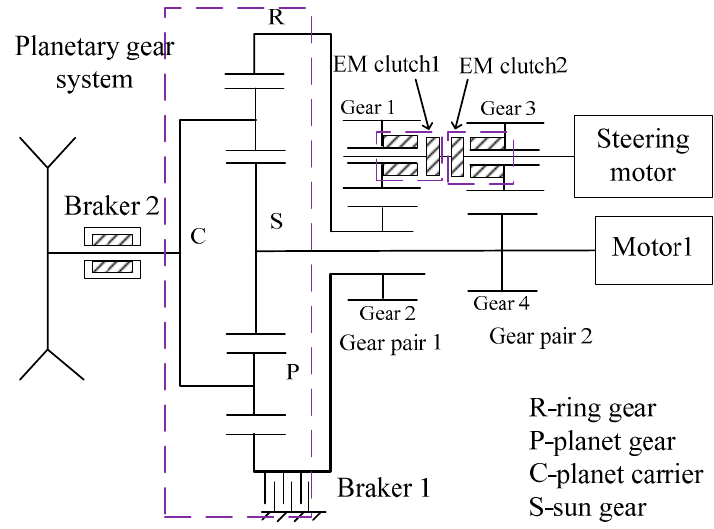
Figure 3. Components of the planetary gear coupler.